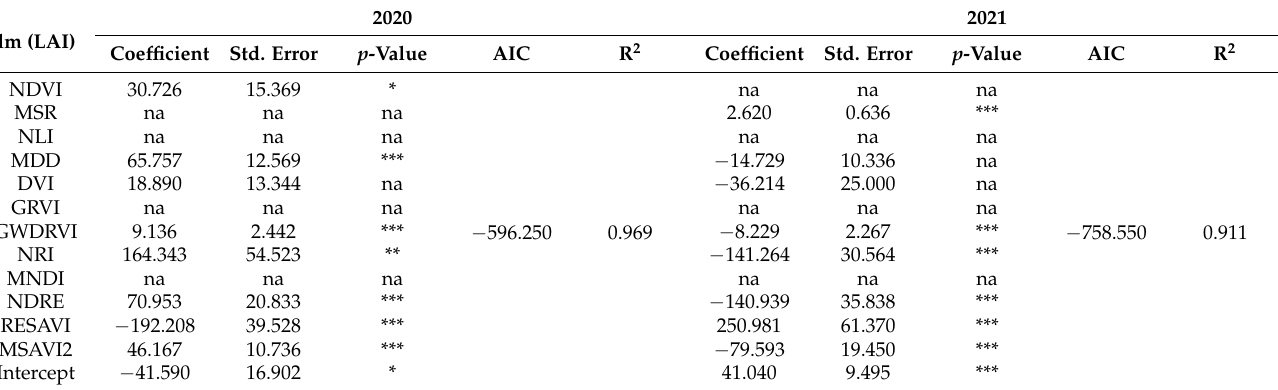
Table 7. Independent variable screening results based on stepwise